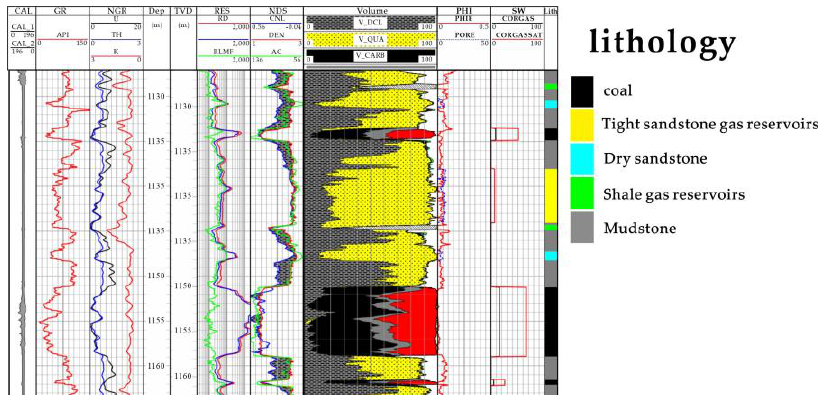
Figure 3. XX − 1 logging interpretation results (Column CAL: borehole diameter curve; Column GR: Gamma curve; Column NGR: energy spectrum curve; Column Dep: depth; Column RES: resistivity curve; Column NDS: Compensated neutron curve, density curve, and acoustic curve; Column Volume: volume of rock physics; Column PHI: porosity curve; Column SW: saturation curve; Column Lith: Lithology).